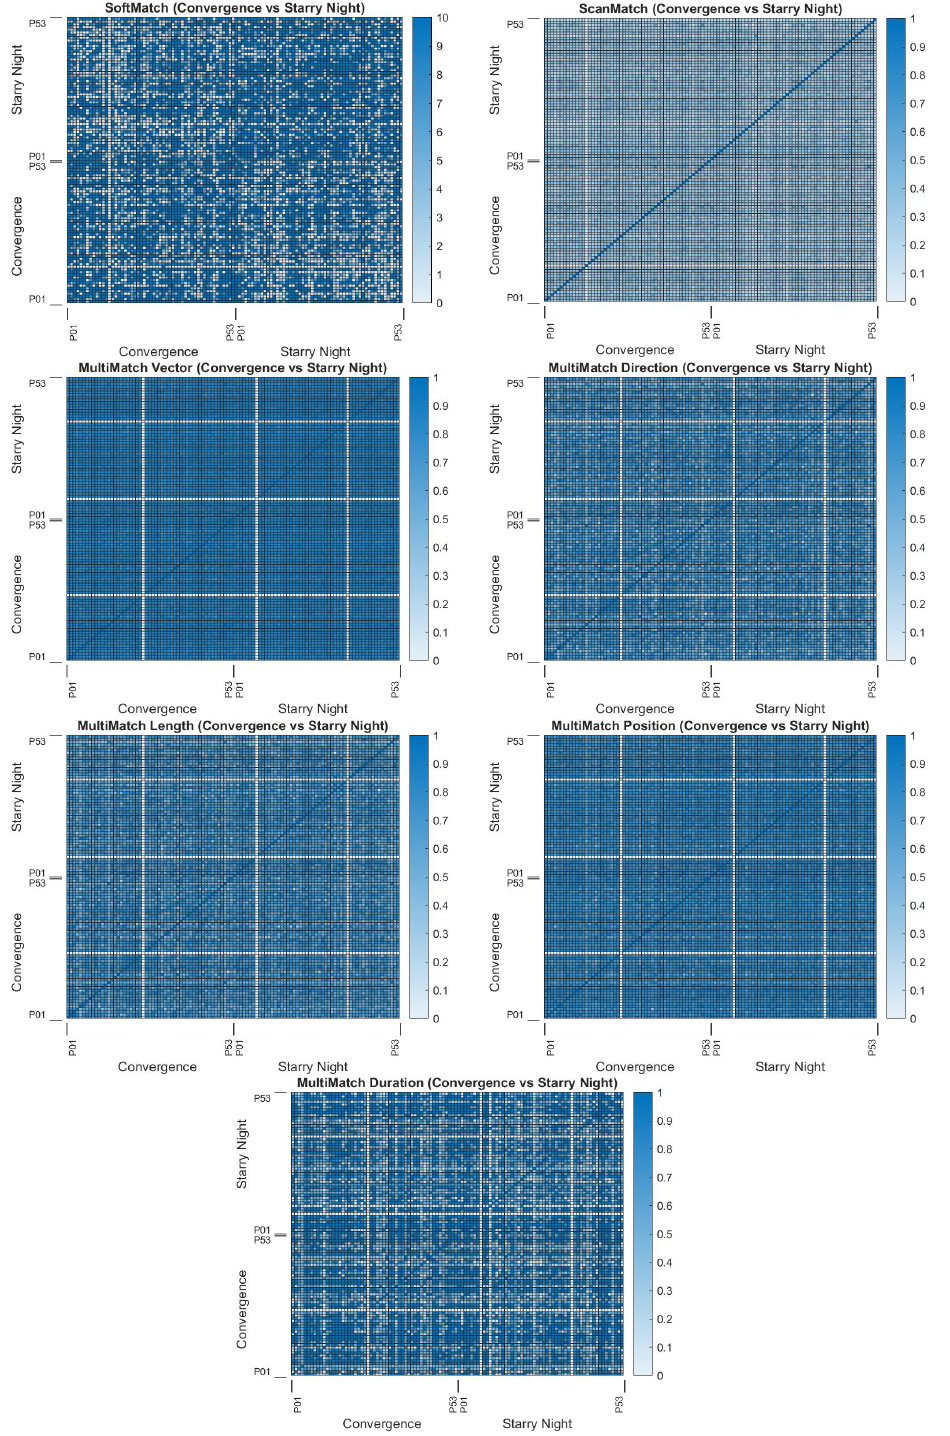
Figure A11. SoftMatch, ScanMatch, and MultiMatch heatmaps for empirical evaluation. Stimuli matched are Jackson Pollock’s Convergence (1952) and Vincent van Gogh’s Starry Night